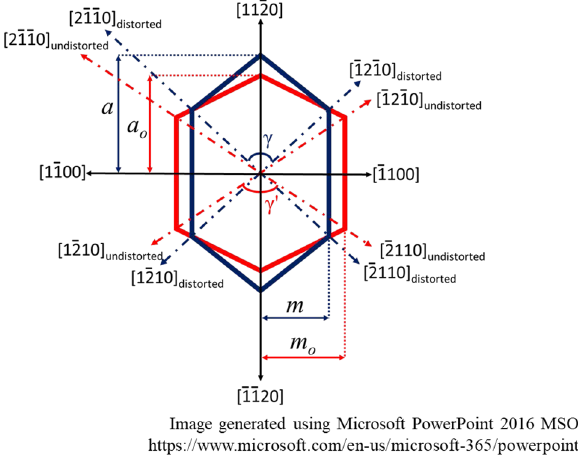
Figure 6. Schematic of perfect (red line) and distorted (dark blue line) wurtzite crystal